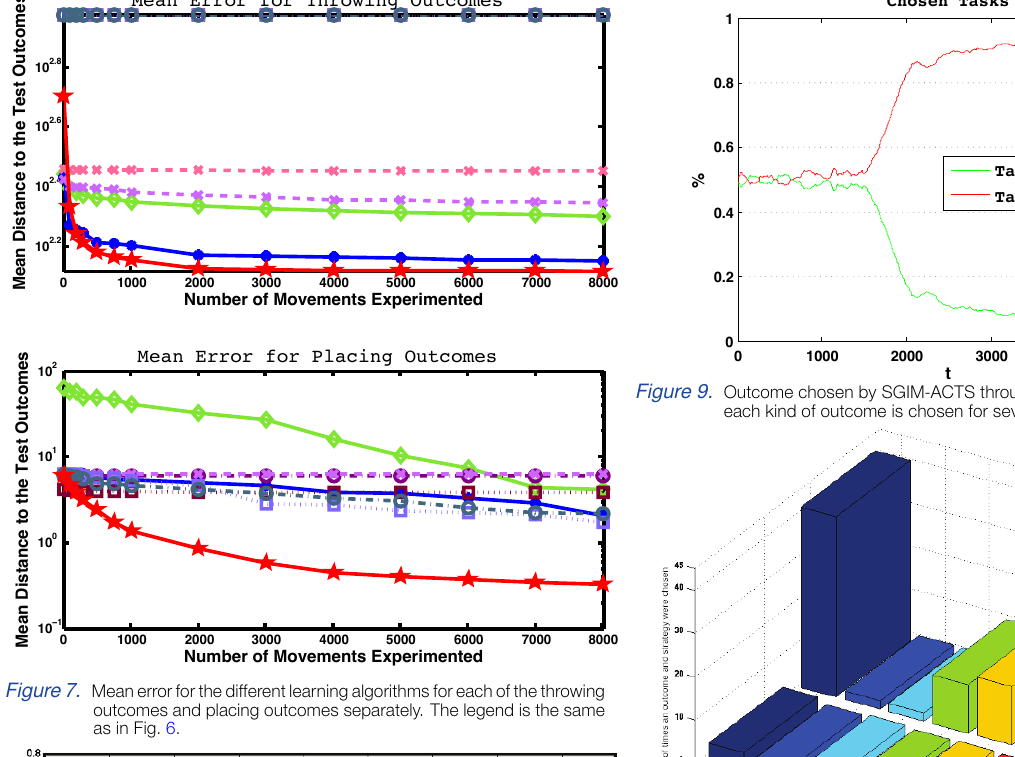
Figure7. Meanerrorforthedi(cid:636)erentlearningalgorithmsforeachofthethrowing outcomes and placing outcomes separately. The legend is the same as in Fig. 6.